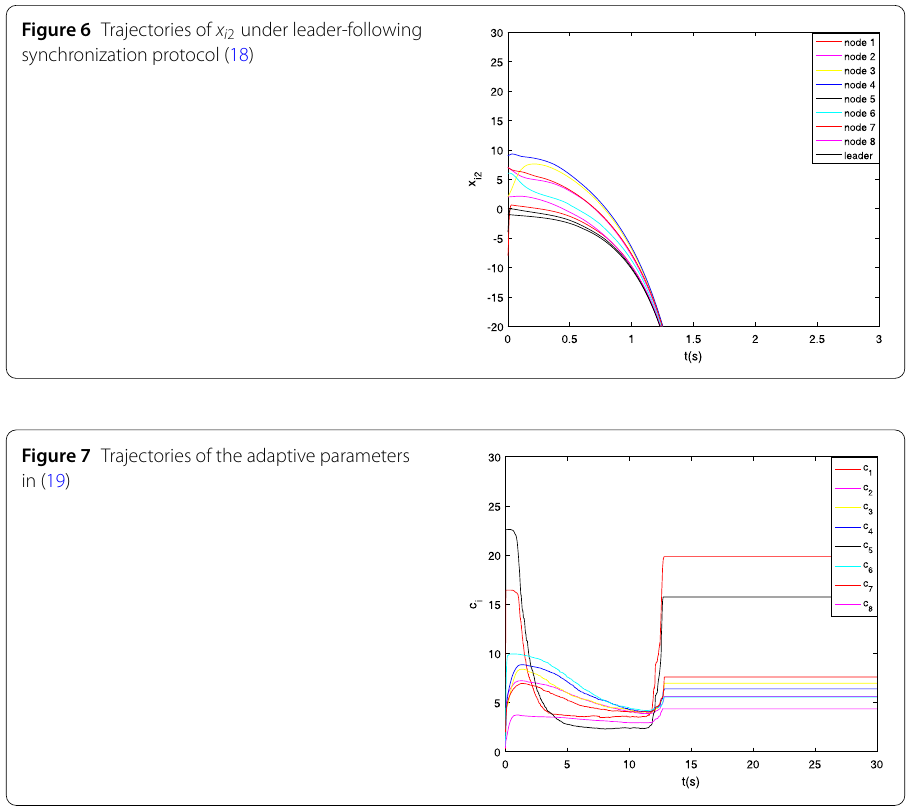
Figure 6 Trajectories of x i 2 under leader-following synchronization protocol (18)